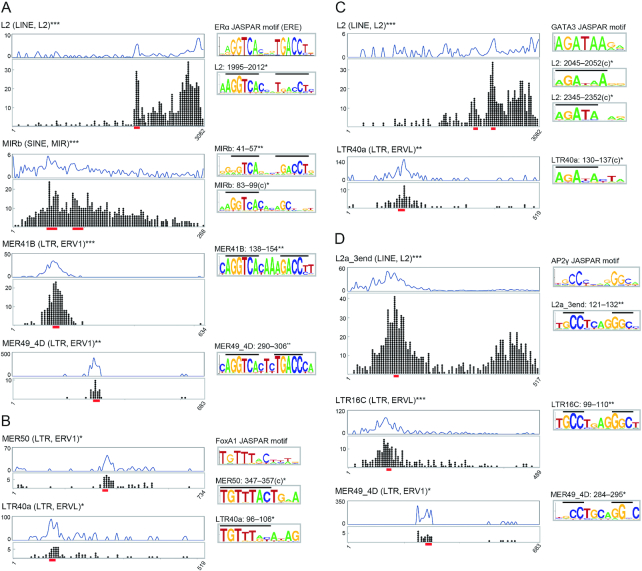
Localized distribution of the transcription factor binding sites and presence of binding motifs in TEs. (A–D) Representative TE subfamilies associated with ERα (A), FoxA1 (B), GATA3 (C) and AP2γ (D). Additional examples are shown in Supplementary Figures S4 and S5. Dot plots represent all binding events where the positions correspond to the TE consensus sequence (x axis). Proportions of the number of binding events (10−5) among all TE copies in the human genome (i.e. the normalized distribution of binding sites) are shown above the dot plots. Asterisks to the right of the TE names indicate the significantly non-uniform distribution of the binding sites within the consensus sequences (two-tailed Fisher's exact test and χ2-test for n ≤ 100 and n > 100, respectively; *P < 0.05, **P < 10–5, ***P < 10–10). In the binding peak regions (red lines), binding motifs were found in the TE sequences (sequence logos on the right) as shown in Supplementary Figure S10. Positions of the binding sites (c, reverse-complement) and the significant presence of the motif in the TE consensus sequences are shown above the logos (*P < 0.05, **P < 10–5; FIMO analysis (34)). Horizontal lines in logos represent conserved nucleotides shared with the known JASPAR motifs shown in the upper right of each panel.